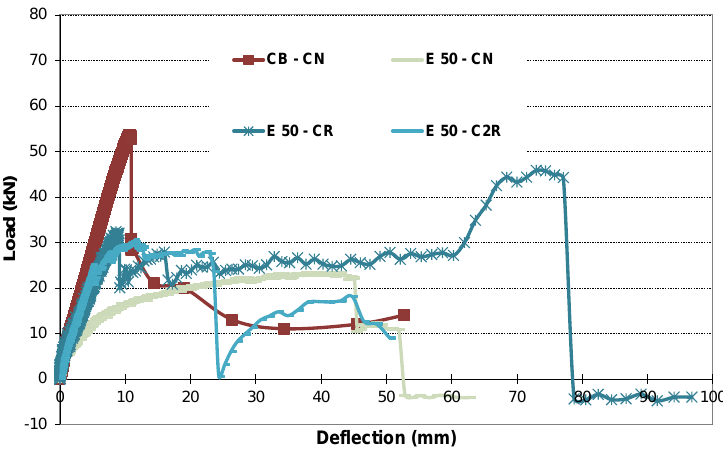
Figure 29. Load-deflection of control beam and beams with 50% corrosion level.